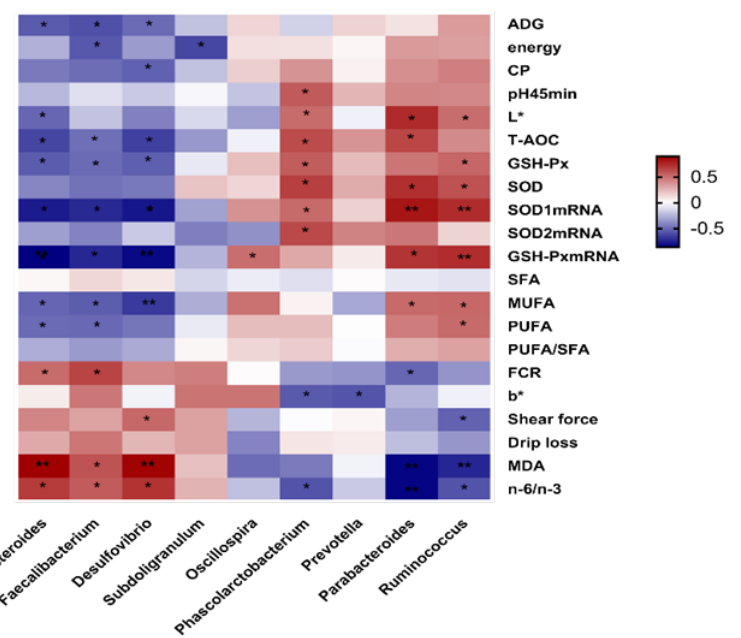
Figure 6. Correlation between the differential cecal microbial community of genera and the phenotype of broilers by Pearson correlation analysis. Red indicates positive correlation and blue indicates negative correlation. (* 0.01 < p ≤ 0.05, ** 0.001 < p ≤ 0.01).